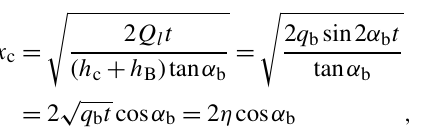
Figure 5. Temporal variations in downdrift control point due to oblique waves within a littoral